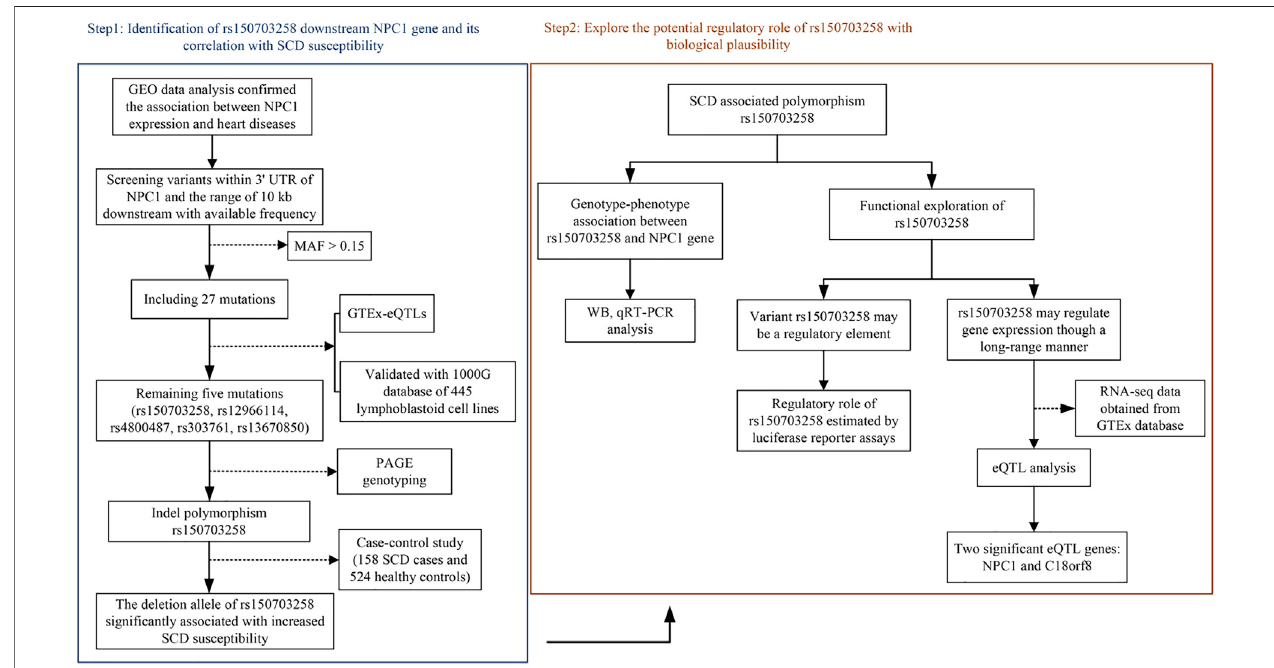
FIGURE 1 | The schematic work fl ow of the present study. GEO: Gene Expression Omnibus; 3 ′ UTR: 3 ′ untranslated region; MAF: minor allele frequency; GTEx: Genotype-Tissue expression; eQTL: expression quality trait loci; PAGE: polyacrylamide gel electrophoresis; SCD: sudden cardiac death.